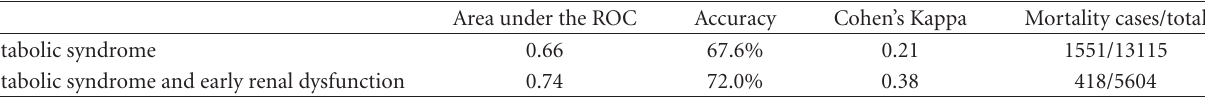
Table 4: Area under the Curve (AUC) for CVD Mortality using unadjusted metabolic syndrome measure compared with cocustered metabolic syndrome and early stage renal